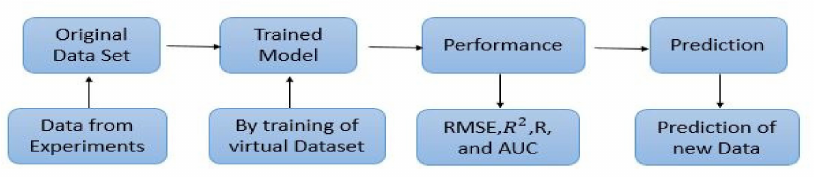
Figure 4. Working of predictive model.